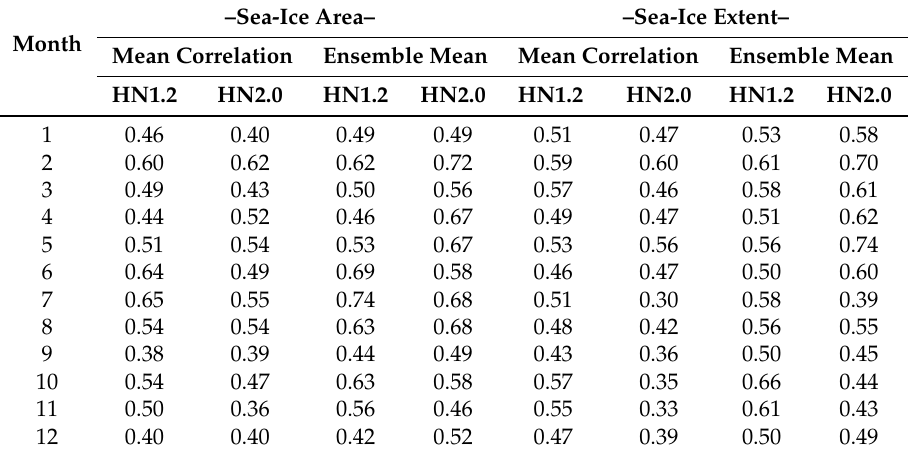
Table 3. Like Table 2, but for simulated and satellite-derived sea-ice area and sea-ice extent. –Sea-Ice Month